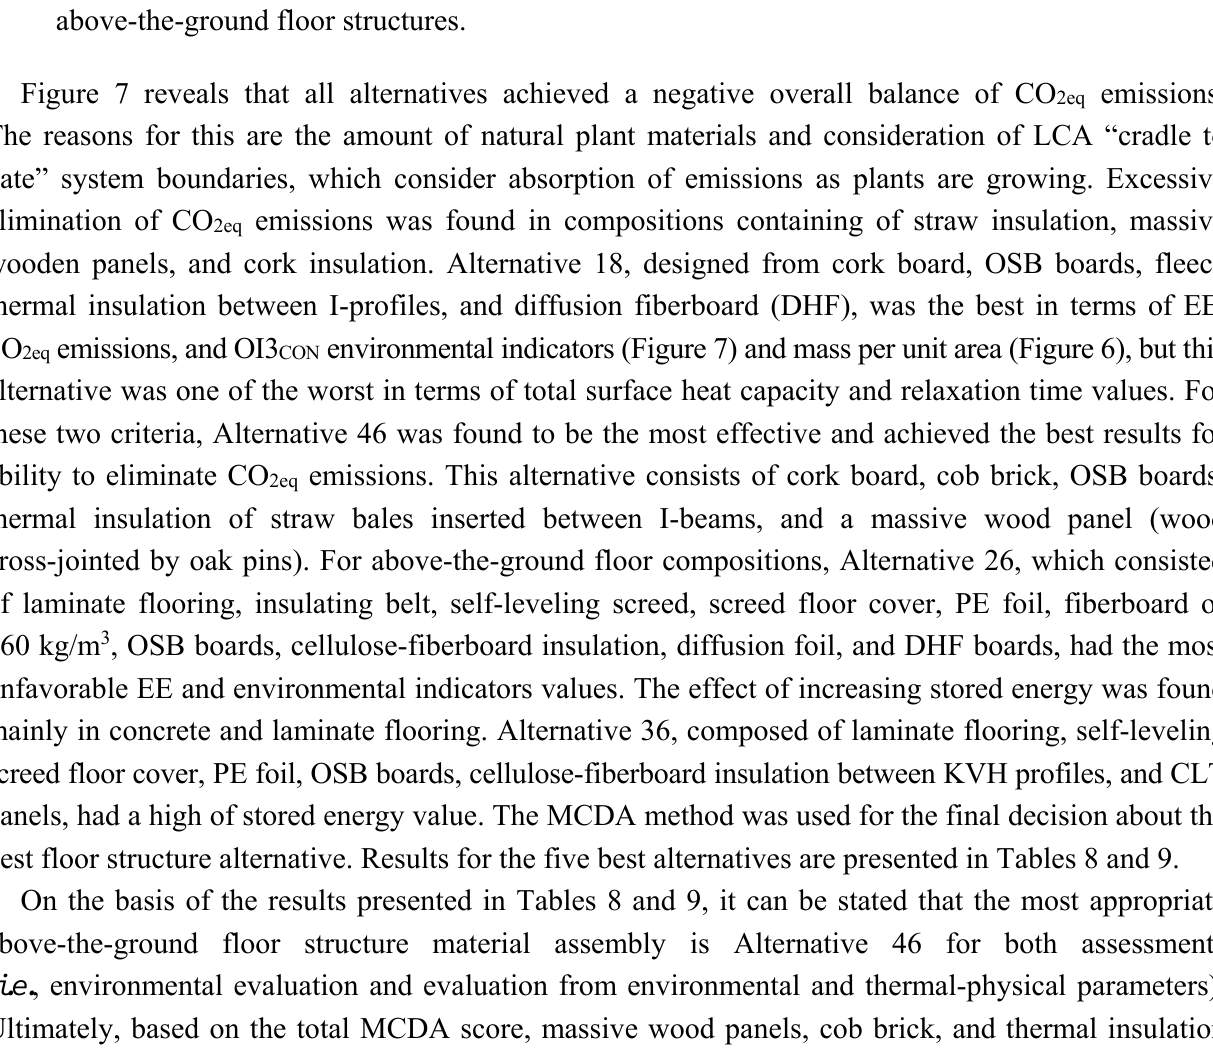
Figure 6. Mass per unit area, phase shift of thermal oscillation, and relaxation time of above-the-ground floor